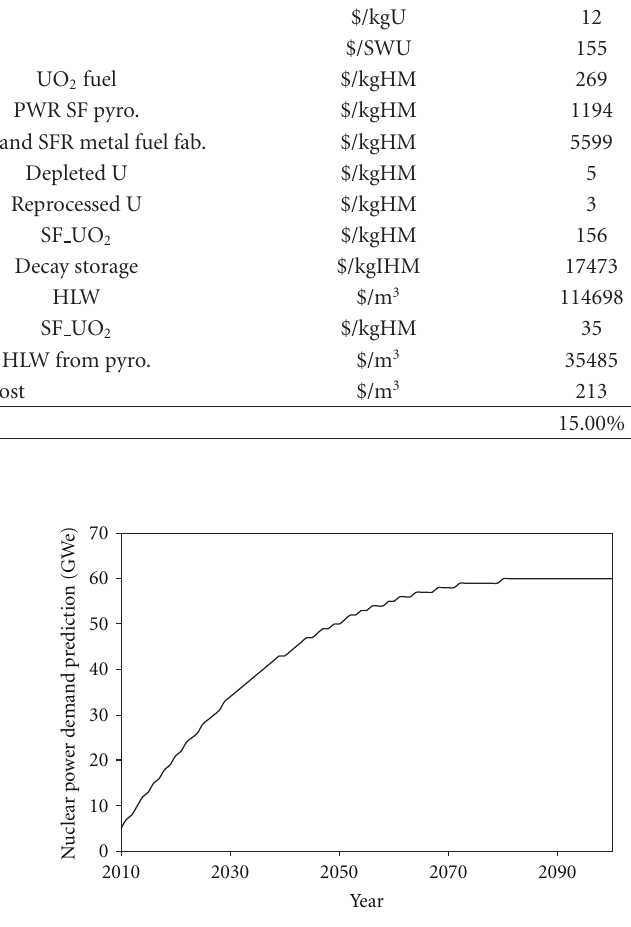
Figure 2: Electricity demand